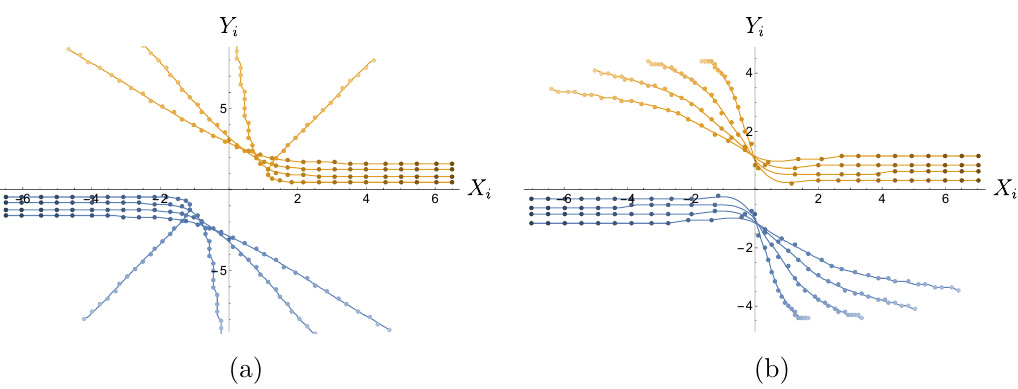
Figure 35 . Trajectories ( X i ( t ) , Y i ( t )) of type II (a) and type I* (b) non-Abelian vortices with parallel internal orientations, scattering with impact parameters b/L = 0 . 25 , 0 . 50 , 0 . 75 , 1 . The vortices start at large values of | X i | (darker points) moving towards the origin with initial velocity u = 0 . 50 , and scatter at increasingly obtuse angles as b/L increases.